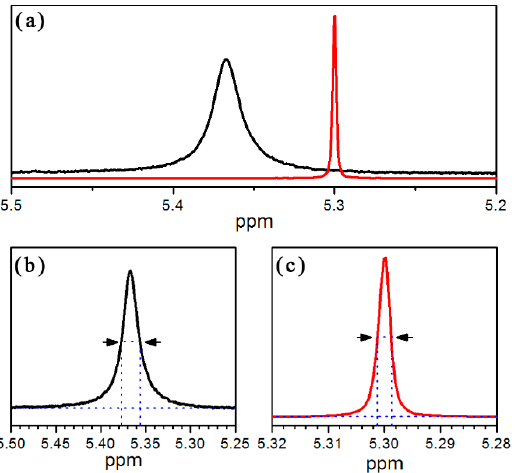
Figure 2. ( a ) 1 H NMR spectra, ( b , c ) the FWHMs of CH 2 Cl 2 ; the black line is the mixture of Pd 8 (PET) 16 and CH 2 Cl 2 , and the red line is the pure CH 2 Cl 2 (CDCl 3 as solvent). Table 1. The structural information of Mn(SR)2n NCs with or without guest